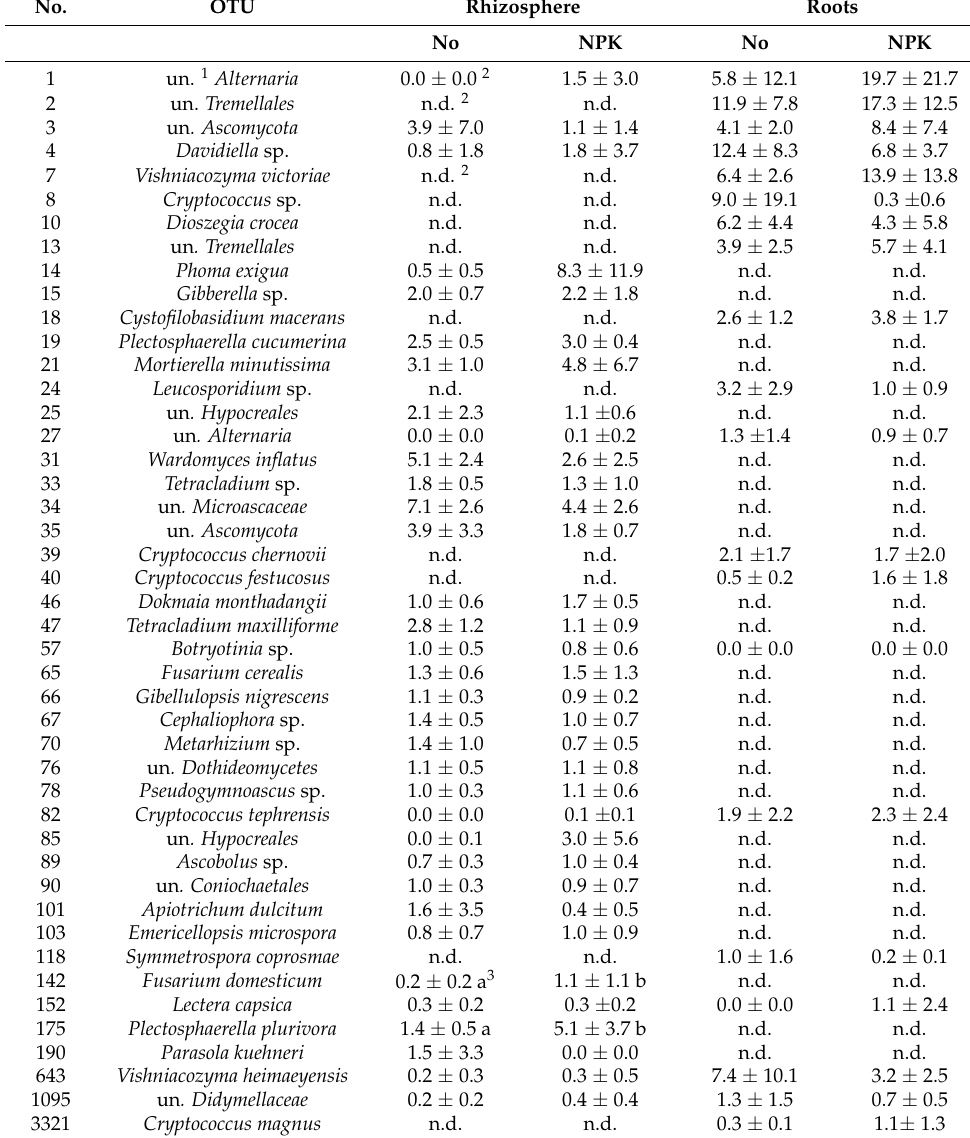
Table 5. The relative abundance (%, mean ± standard deviation) of the dominant fungal OTUs in the rhizosphere and roots of tomato plants grown under different fertilization on Phaeozem in the open field in the south of West Siberia (an OTU was considered dominant if its relative abundance was ≥ 1.0%).